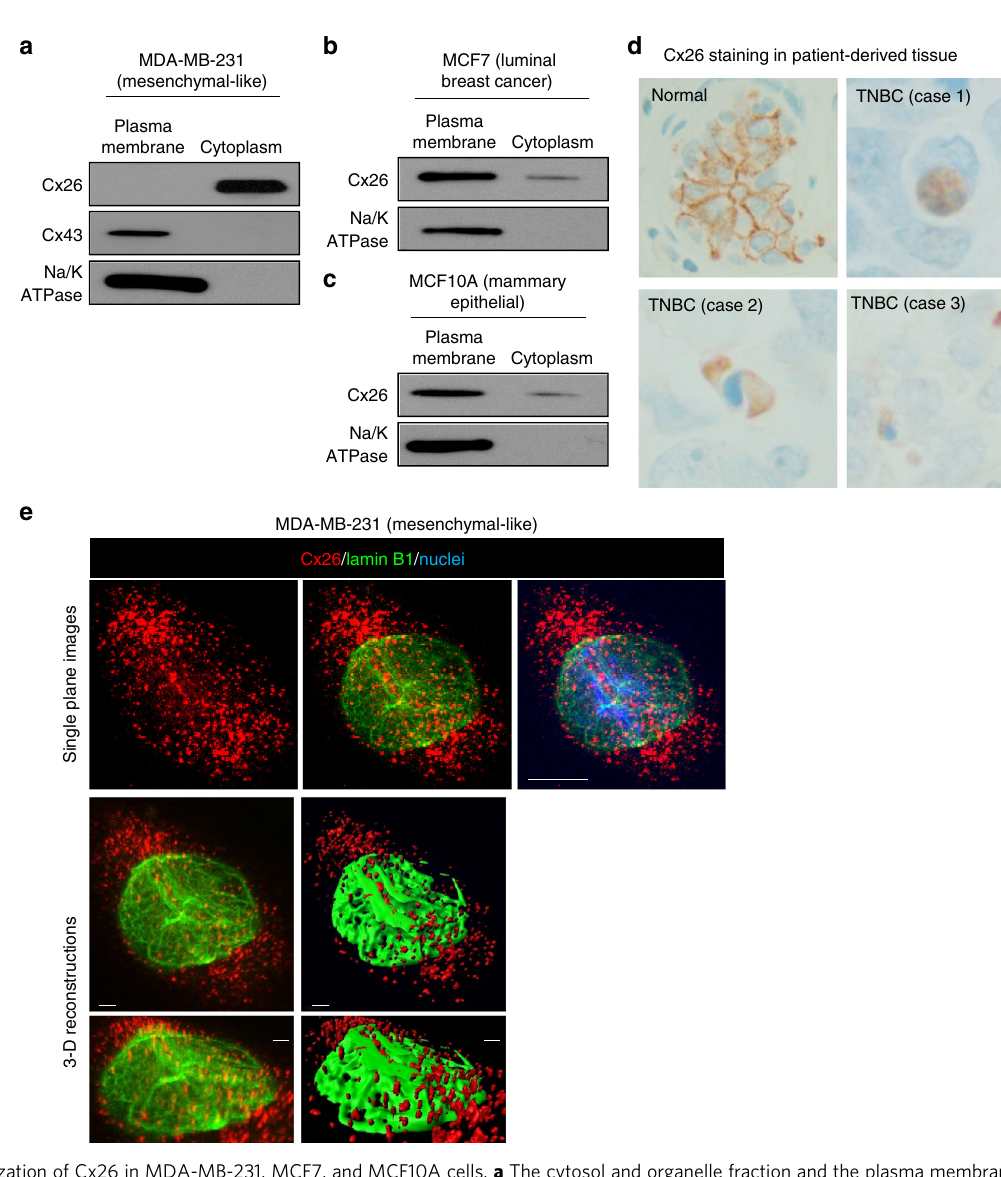
Fig. 3 Localization of Cx26 in MDA-MB-231, MCF7, and MCF10A cells. a The cytosol and organelle fraction and the plasma membrane fraction of MDA- MB-231 parental cells were probed for a plasma membrane marker (sodium potassium ATPase), Cx26, and Cx43 by immunoblotting. b , c Cx26 localization in MCF7 and MCF10A cells was determined by immunoblotting of the plasma membrane and the cytosol and organelle fractions with Na/K ATPase as an indicator of plasma membrane fraction quality. d Immunohistochemistry micrographs demonstrate the staining pattern of Cx26 (brown) in normal and adjacent TNBC tissue from three patients. Nuclei were counterstained in blue. Images provided at 400×. e Confocal micrographs of MDA-MB-231 TNBC cells stained with antibodies against Cx26 (red) and lamin B1 (green). Single plane images and 3-D reconstructions of areas were generated in Imaris. Corresponding fl uorescent images are provided above 3-D reconstructions. Nuclei were counterstained with Hoechst 33342, and scale bars are provided on each micrograph and